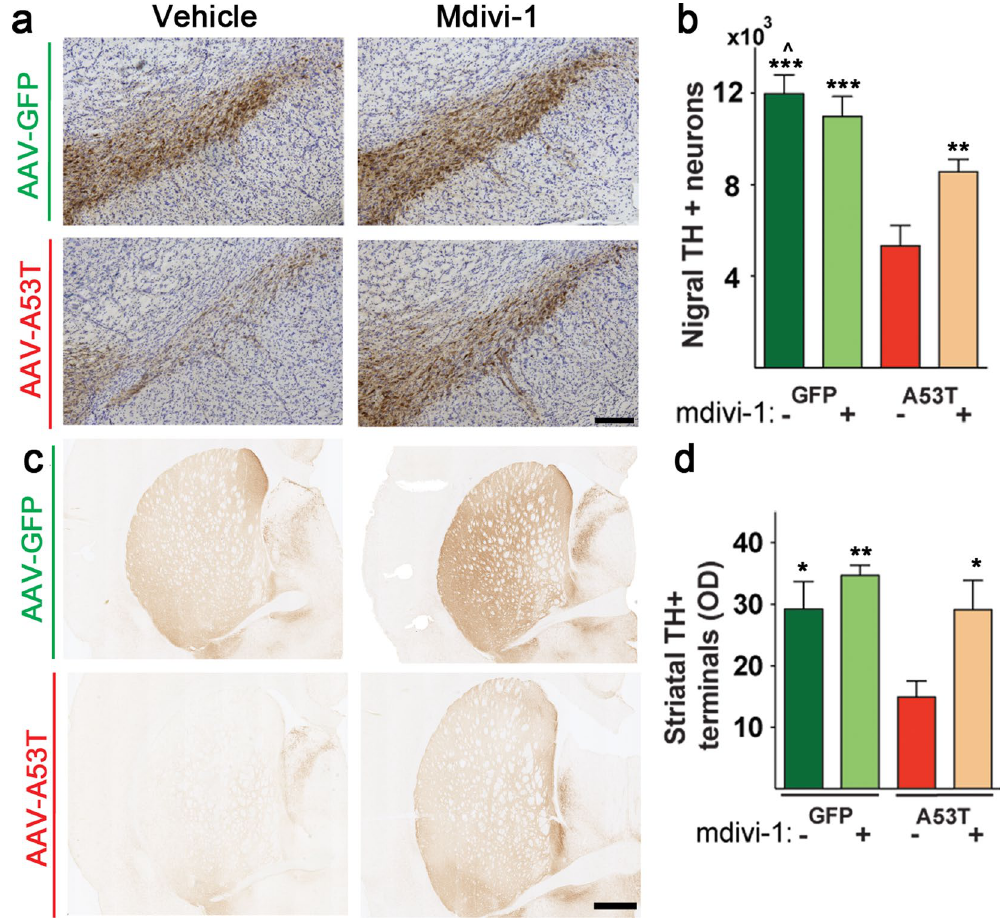
Figure 2. Mdivi-1 attenuates nigrostriatal degeneration induced by hA53T- α -syn. ( a ) Representative pictures of TH immuno-staining in SNc, scale bar 200 μ m. ( b ) Stereological quantification in SNc showing a decrease in the total number of TH positive neurons in animals expressing hA53T- α -syn. The decrease was prevented in A53T rats injected with mdivi-1. ( c ) Representative pictures of TH staining in striatum. Scale bar 1 mm. ( d ) Optical density of TH positive fibers was reduced in rat expressing hA53T- α -syn compared to GFP and preserved in mdivi-1-treated A53T animals. ( b,d ) Values are means ± SEM of 7–8 rats analysed using two- way ANOVA ( b) , AAV injection: F 1,26 = 43.79 p < 0.001; treatment: F 1,26 = 3.919 p = 0.0584; AAV injection x treatment: